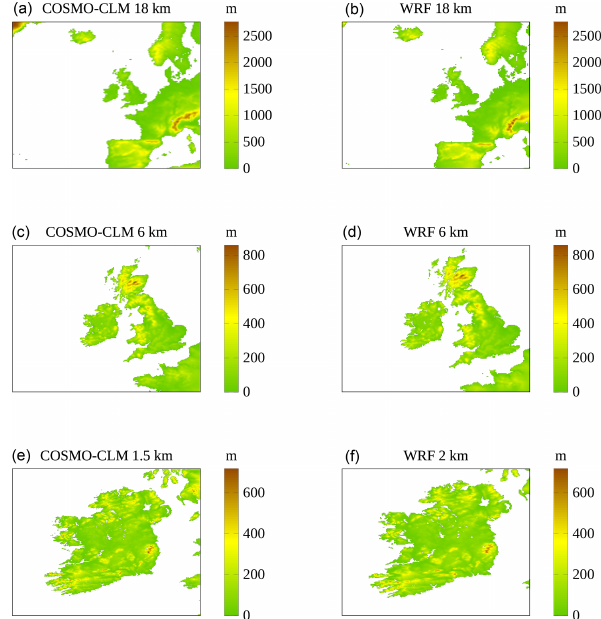
Figure 1. The nested domains used for the COSMO-CLM (a, c, e) and WRF (b, d, f) model runs showing model topography at three spatial resolutions; 18km (a, b) , 6km (c, d) and 2km (e, f)